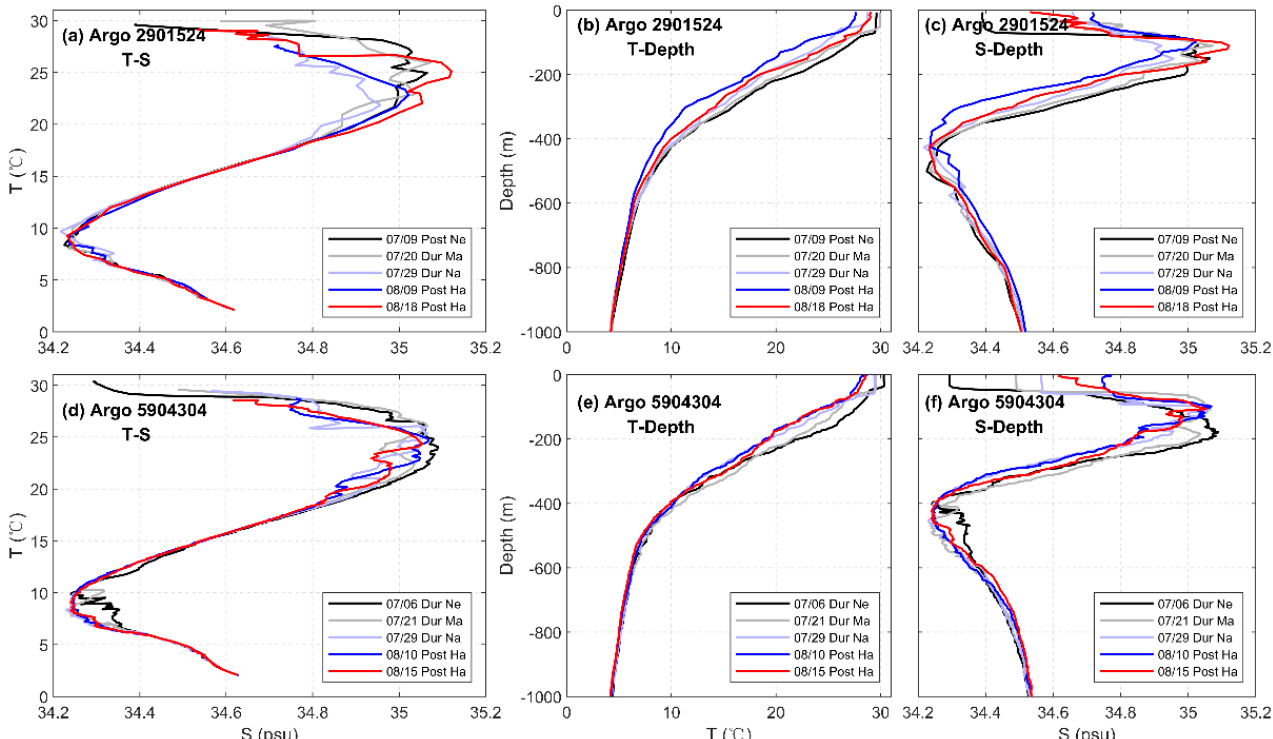
Figure 6. Temperature and salinity profiles measured by Argos 2901524 (a-c) and 5904304 (d-f). TC Neoguri, Matmo, Nakri, and Halong were abbreviated to Ne, Ma, Na, Ha. Pre, Dur and Post indicated Pre-TC, During TC and Post-TC, respectively.